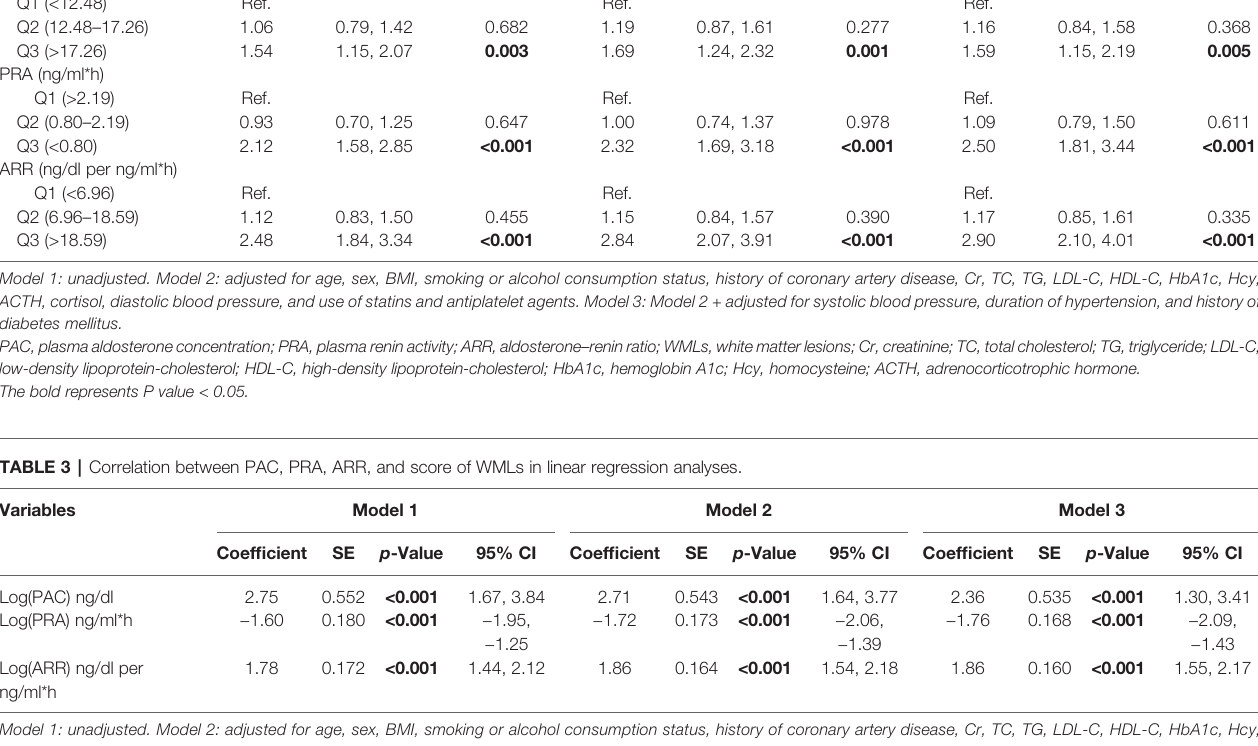
PAC (ng/dl) Q1 (<12.48)